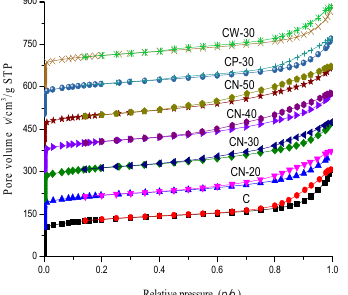
Figure 8. The low-temperature N 2 adsorption and desorption isotherms of the Figure 8. The low ‐ temperature N 2 adsorption and desorption isotherms of the catalysts. The low ‐ temperature N 2 adsorption and desorption results of the catalysts are shown in Table 2. The raw powder HZSM ‐ 5 has a high BET surface area, reaching 481.65 m 2 /g. With an increase in binder content, the BET surface area and micropore surface area of the catalysts gradually decreases. The order of external surface area is CZ > CN ‐ 50 > CN ‐ 30 > CN ‐ 4 ≈ CP ‐ 30 > CW ‐ 30 > CN ‐ 20, and the changeable rule of the external surface area with the binder content and molding method is not obvious. The external surface area of CN ‐ 20 is the minimum, and that of CN ‐ 50 is the maximum. There is a little dif ‐ ference in the external surface area, which is no more than 20 m 2 /g. The total pore volume of CZ is the largest, reaching 0.4763 cm 3 /g. The total pore volume decreases with the ad ‐ dition of the binder, the micropore volume decreases with an increase in binder content and the mesopore pore volume slightly increases with an increase in binder content. The pore size of γ‐ Al 2 O 3 obtained by calcined pseudoboehmite is larger than that of HZSM ‐ 5 zeolites, and some pseudo boehmite binders may block the micropores; therefore, the micropore volume of the catalyst decreases and the mesopore volume increases gradu ‐ ally with an increase in binder content [25]. The BET surface area, micropore surface area and micropore surface area of the CN ‐ 30, CP ‐ 30 and CW ‐ 30 catalysts prepared by three different molding methods have little difference, with the maximum difference being 10.39 m 2 /g. The decreasing degree of micropore volume and mesopore volume of CP ‐ 30 is higher than that of CN ‐ 30 and CW ‐ 30, which indicates that the mechanical mixing method has a more obvious influence on pore structure than the other two methods. The mechanical mixing method is not conducive to the formation of mesopores and is easier to block micropores with. Because the crystal of HZSM ‐ 5 zeolites used in this experiment is nanometer size, the largest intercrystal pore has been formed by nano ‐ HZSM ‐ 5 crys ‐ tals, which leads to a lesser degree of influence of the pseudoboehmite binder on the